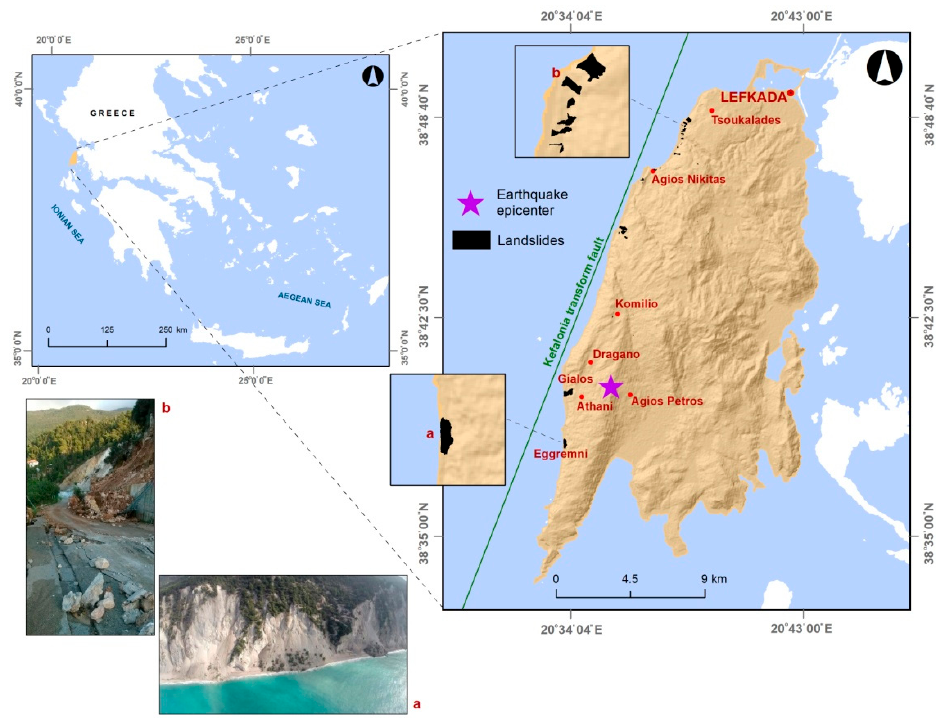
Figure 1. The landslide inventory map, including location map and images illustrating two landslide events triggered by the 17th November 2015 earthquake in the island of Lefkada: ( a ) Earth slide on the Eggremni beach; ( b ) Rock slide on the road axis from Tsoukalades to Agios Nikitas.